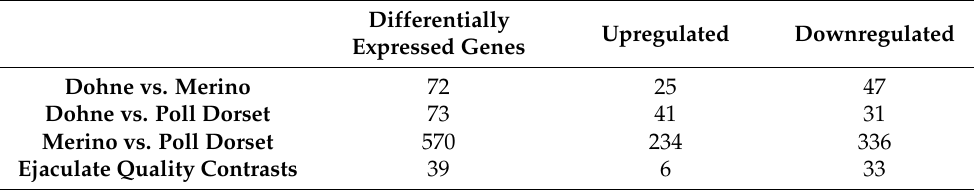
Table 3. Numbers of differentially expressed genes for the comparison of treatment groups.